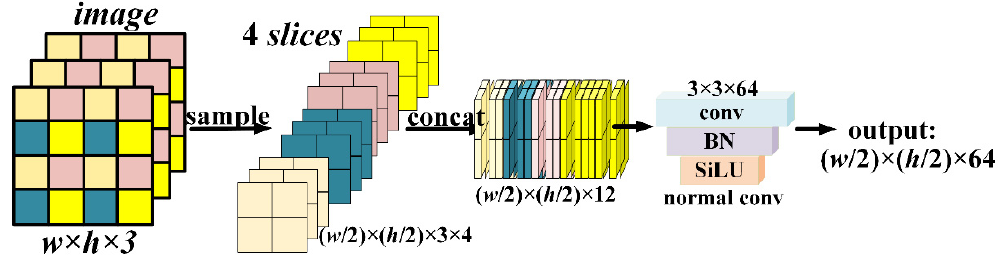
Figure 7. Focus module with parameter details.